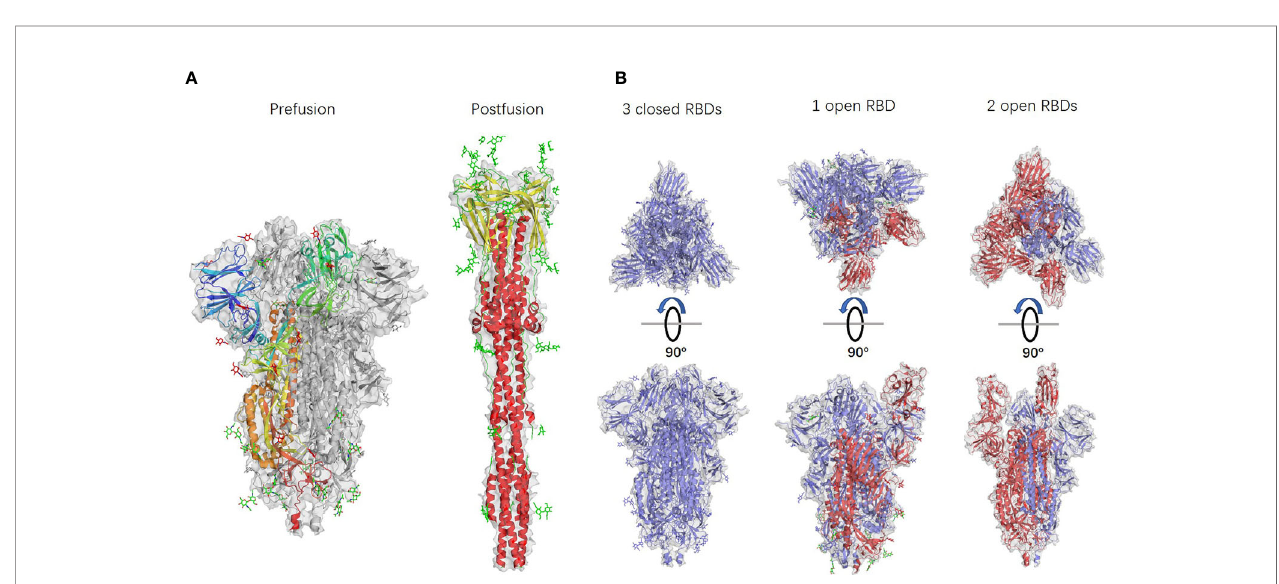
FIGURE 2 | Different S-trimer conformations. PDB accession numbers: 6 VXX, 6 XRA, 6 VXX, 6 VYB, and 6 X2B from left to right. (A) S-trimer models in prefusion and postfusion forms. (B) S-trimer models with different RBD forms. S-monomers with closed RBDs are shown in blue, and open RBDs are shown in